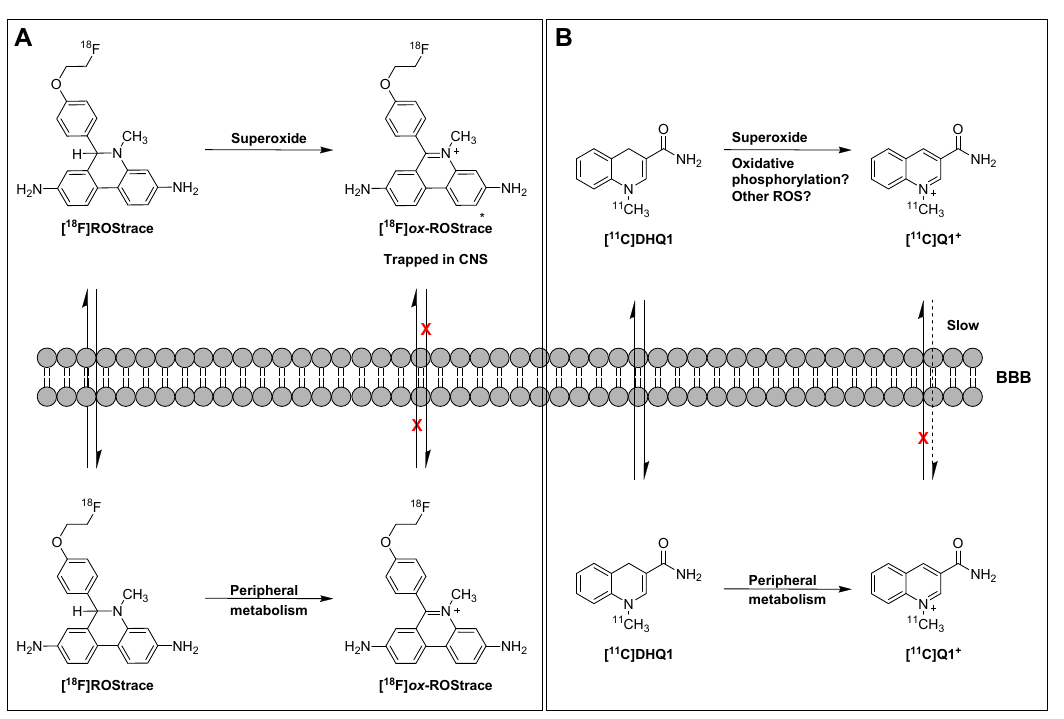
Figure 7. Mechanism of trapping of [ 18 F]ROStrace ( A ) and [ 11 C]DHQ1 ( B ).